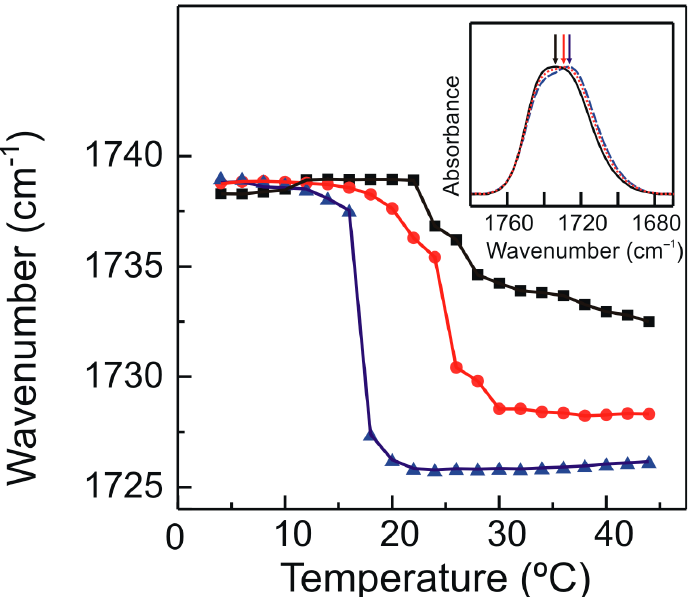
Figure 6. Temperature dependence of the wavenumber of the maximum of the ester carbonyl stretching band, ν (C=O), exhibited by pure DMPG (black squares) and DMPG containing TMBC 0.07 (red circles) and 0.20 (blue triangles) mole fraction. Inset shows the 1780–1670 cm − 1 spectral region containing the absorption band originating from the ester carbonyl stretching band of pure DMPG (black solid line) and DMPG containing TMBC at 0.07 (red dotted line) and 0.20 (blue dashed line) mole fraction, at 35 °C. Arrows point to the wavenumber of the maximum of each band at this temperature.